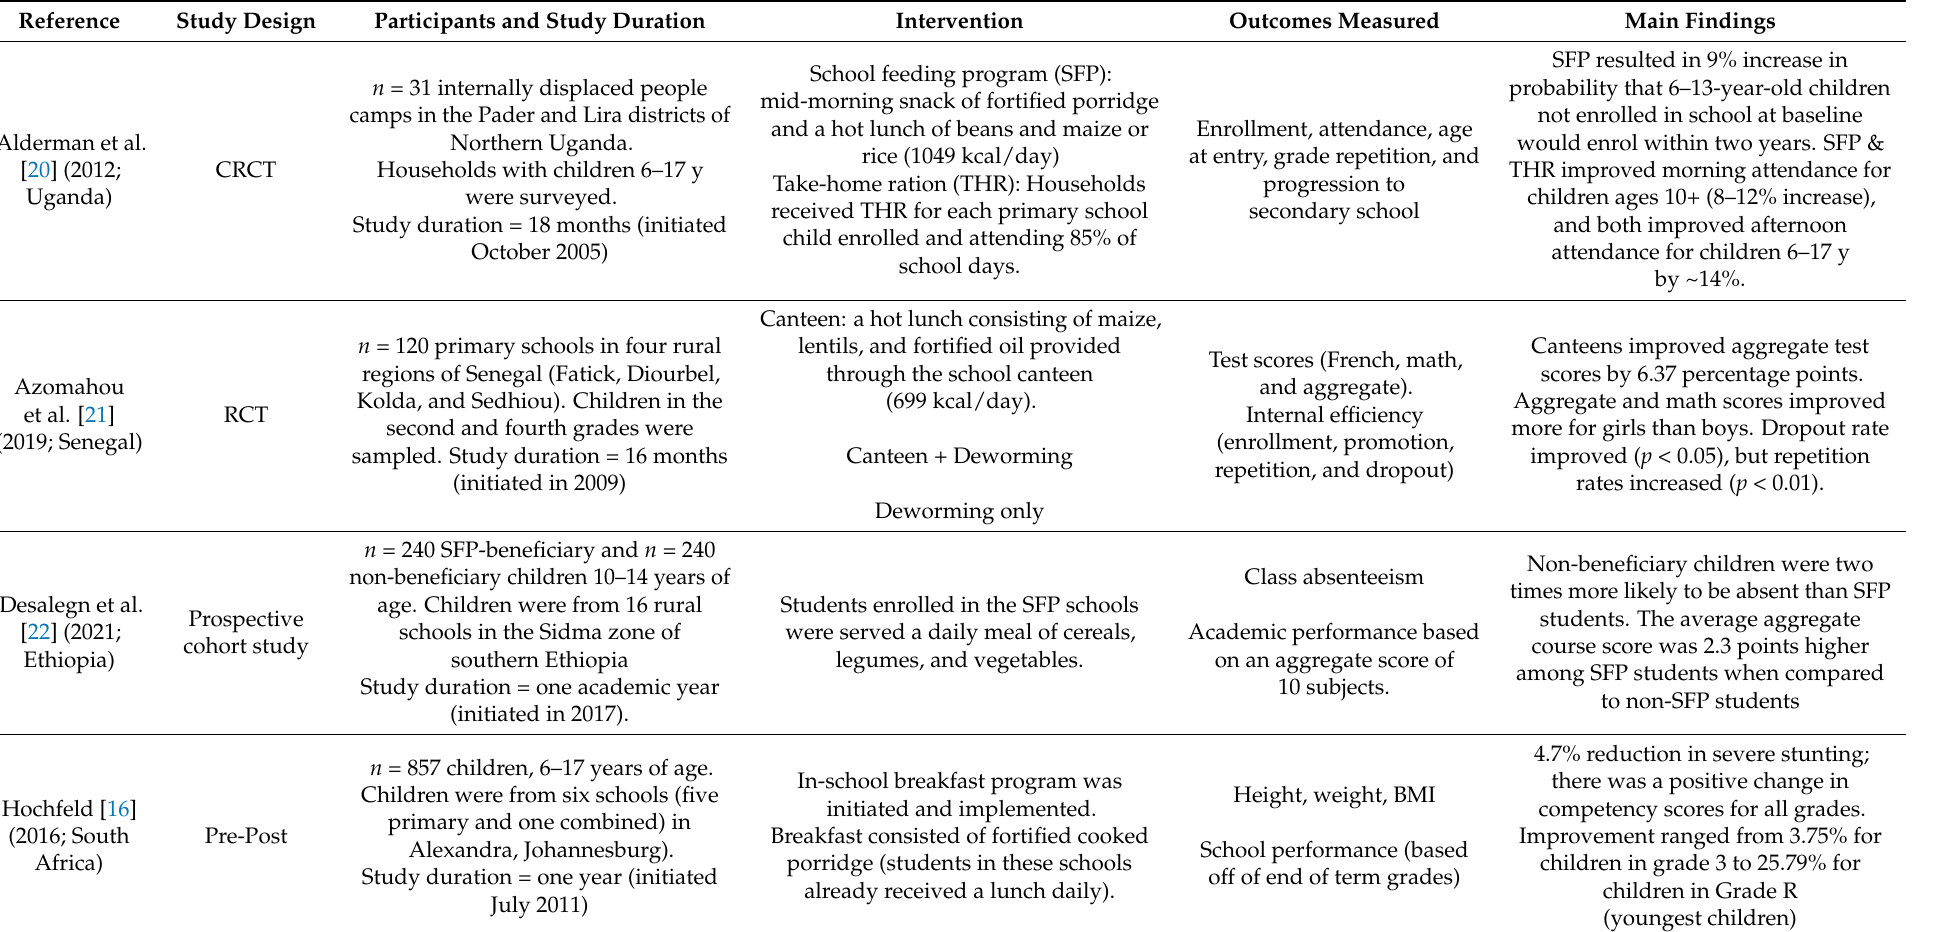
Table 2. Summary of included articles discussing the impact of school meal interventions on educational outcomes among preschool and primary school age children in